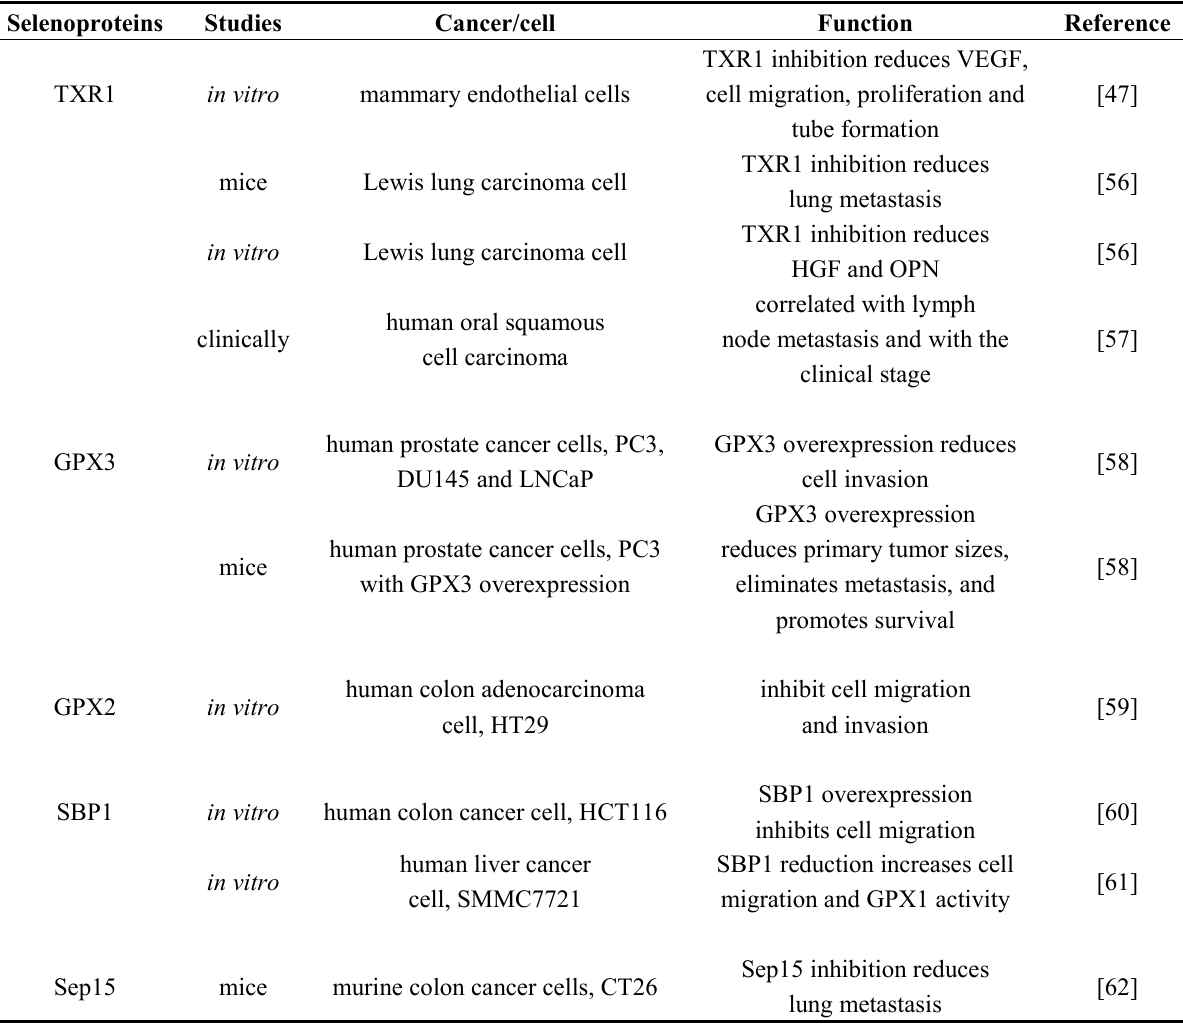
Table 2. Selenoproteins involved in